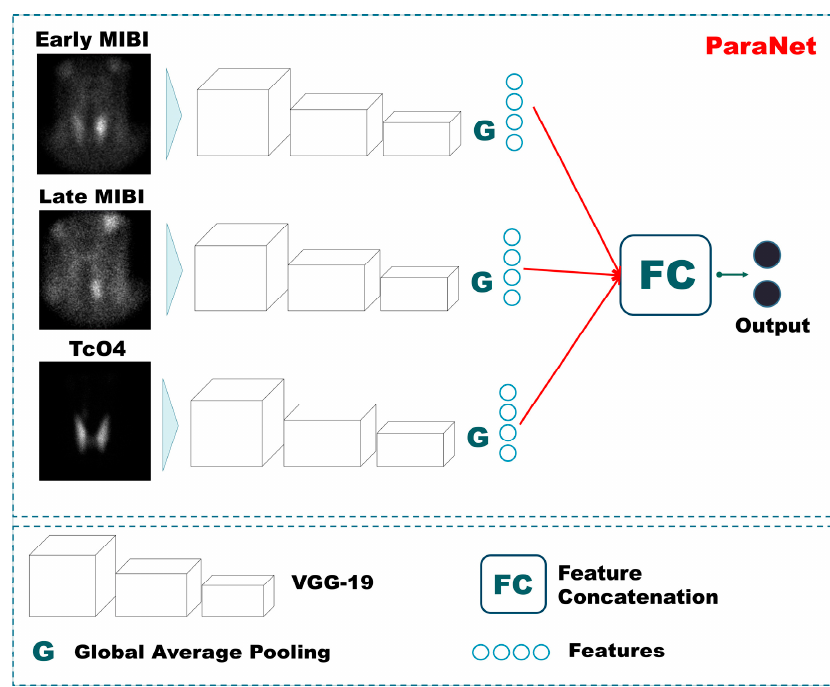
Figure 1. ParaNet